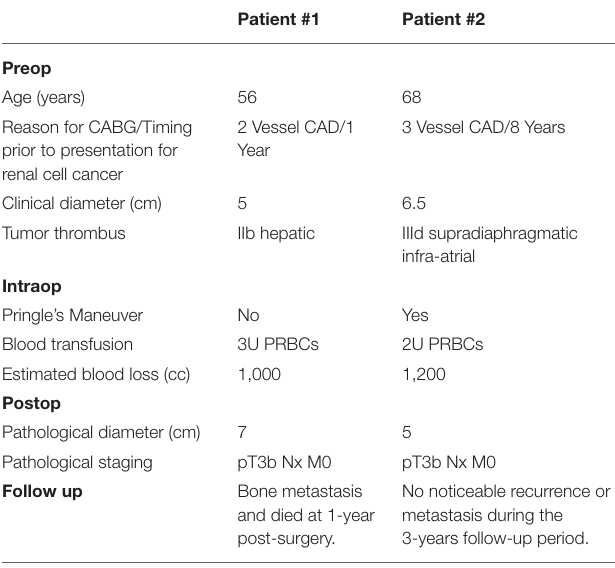
TABLE 1 | Perioperative characteristics of Patient #1 and Patient